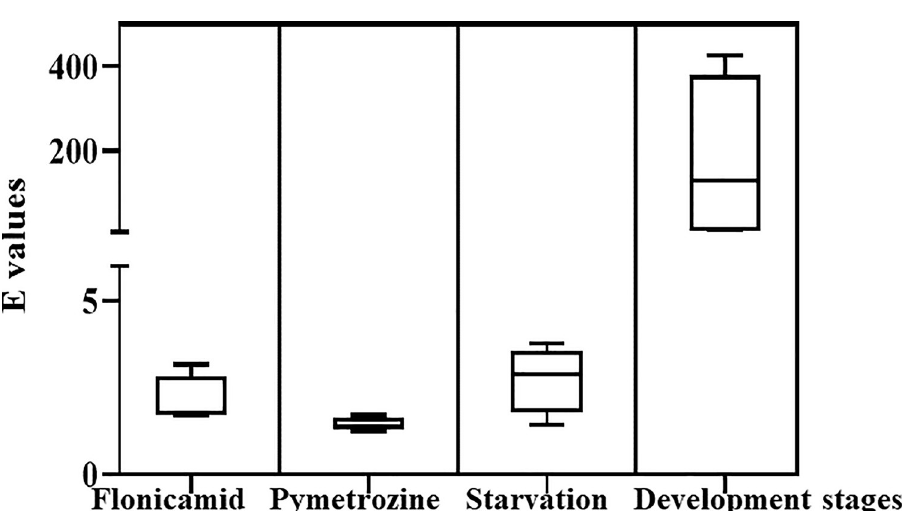
Fig 5. Single control normalization error E for four target genes under different biotic and abiotic conditions in M . persicae . The boxes indicate the 25th and 75th percentiles. Lines across the boxes represent the medians, and upper and lower dots represent the maximum and minimum values, respectively.